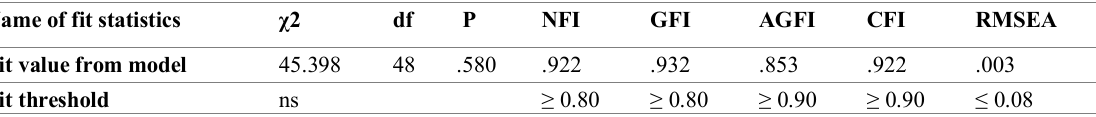
Table 3: Model fit indices of opportunity discovery-growth model